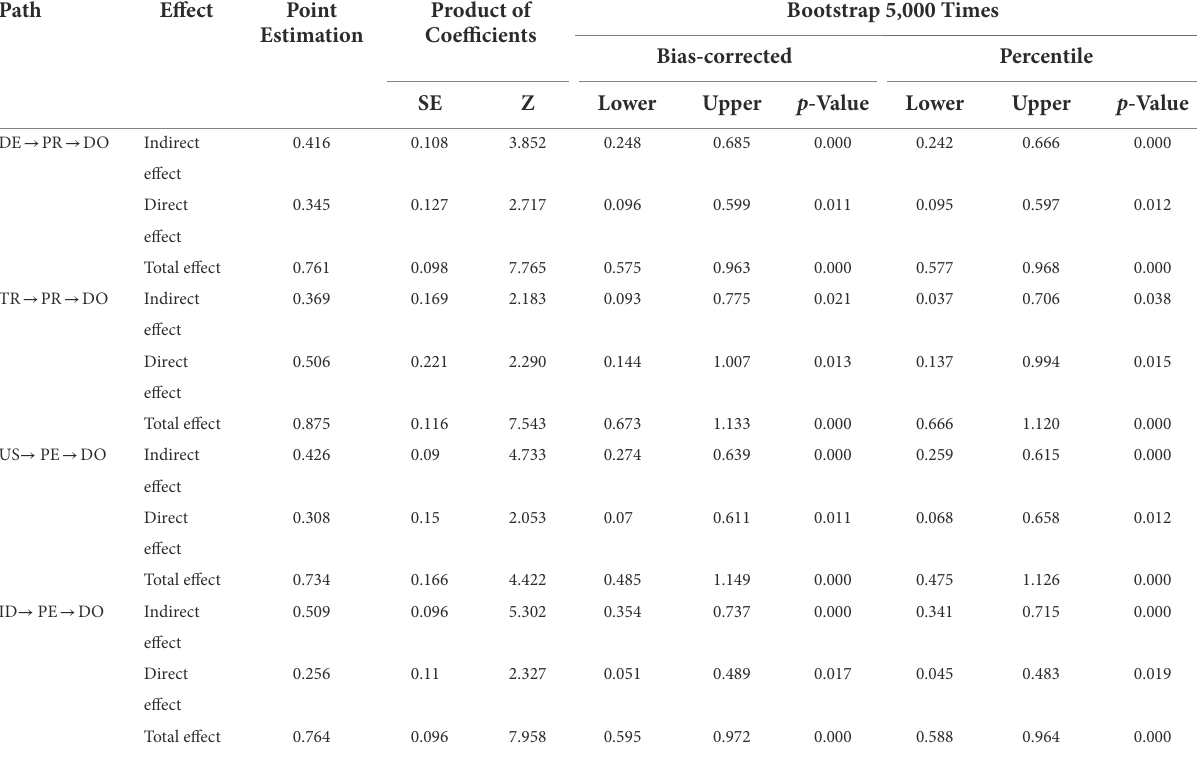
TABLE 5 Test Results of the bootstrap mediating